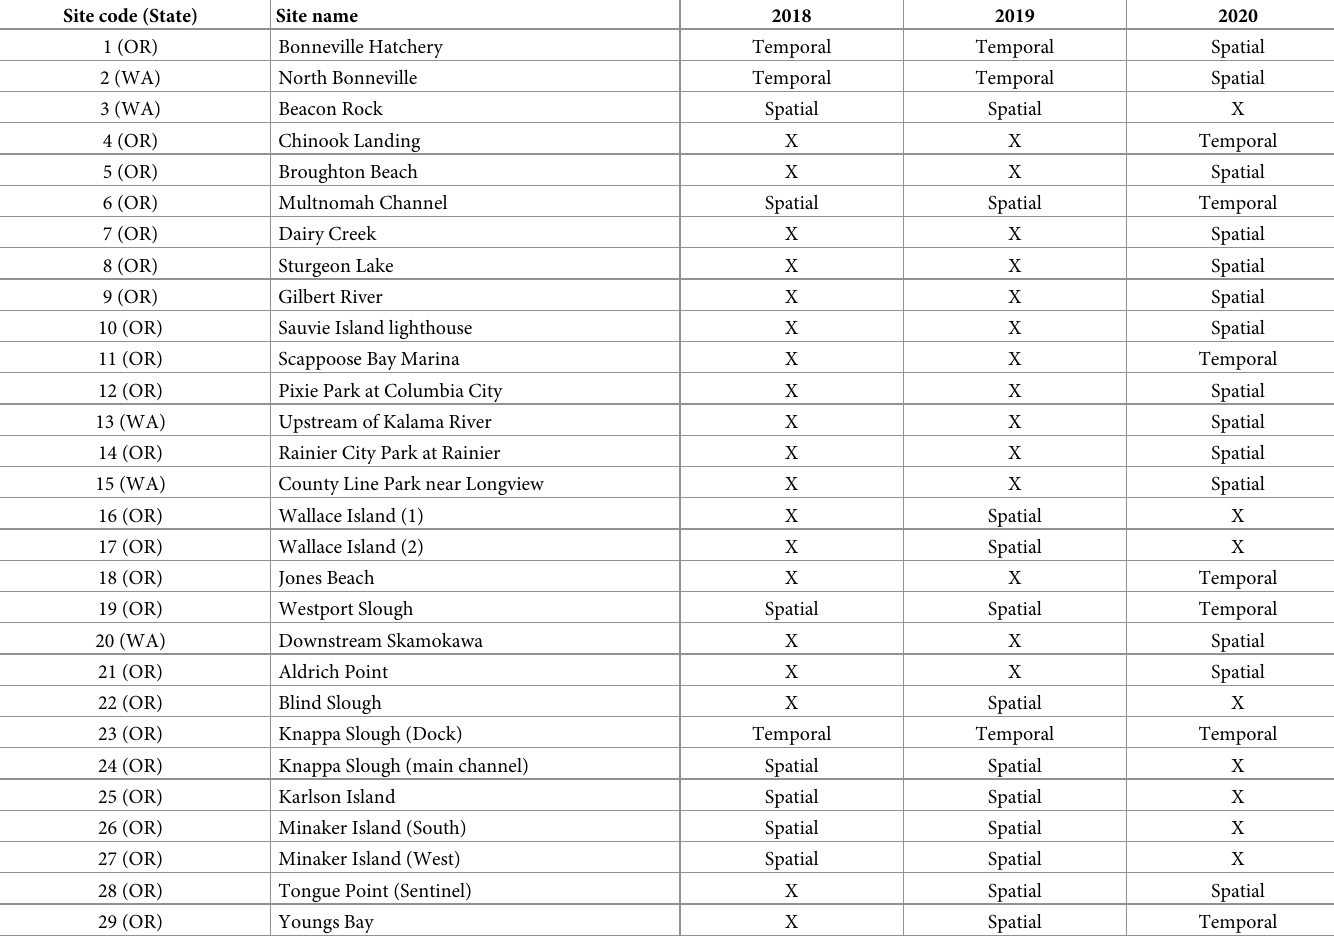
Table 1. Site code, site name, and sample type by year for Columbia River sites sampled for Ceratonova shasta , 2018–2020. “X” indicates site not sampled during a given year. Site code